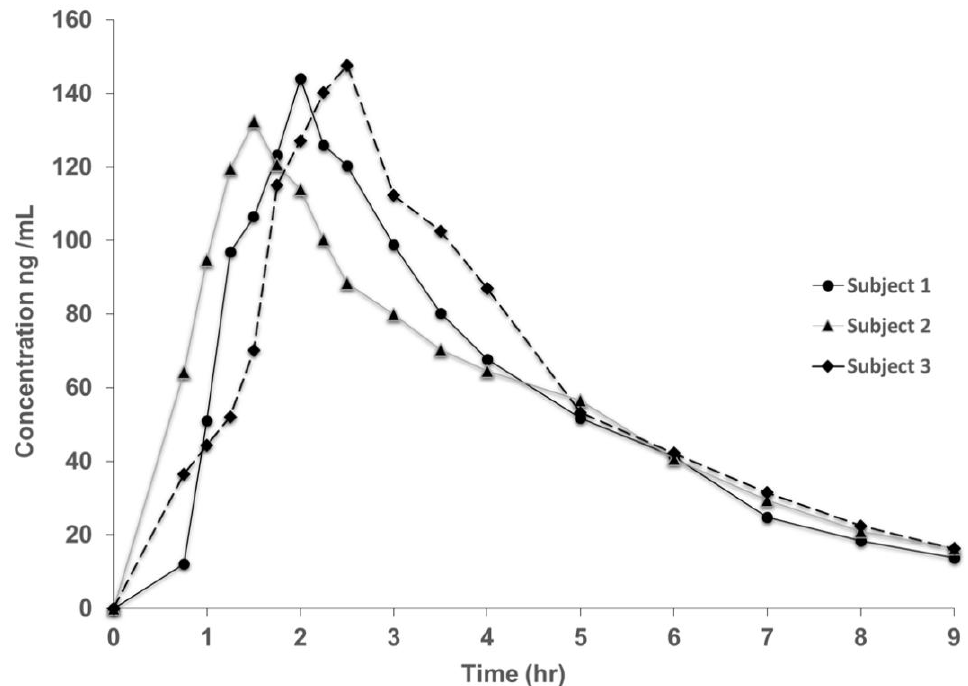
Figure 5. Plasma concentration–time curves of folic acid after oral administration of 5 mg folic acid to three healthy subjects.